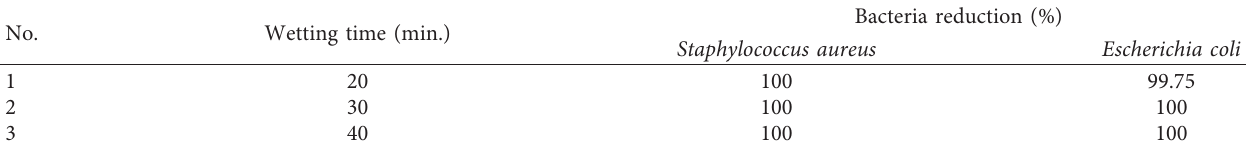
Table 9: Bacterial reduction test on the Pad-Dry-Cure treated